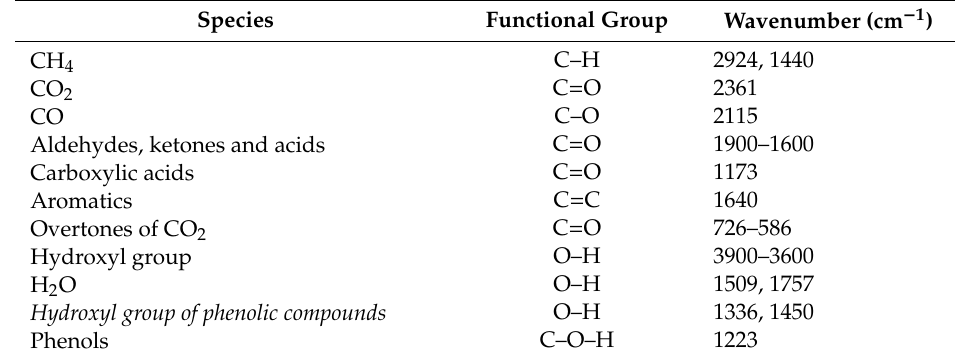
Table 2. Assignment of the observed bands to the functional groups during the pyrolysis and combustion of sugarcane residual biomass [62,63]